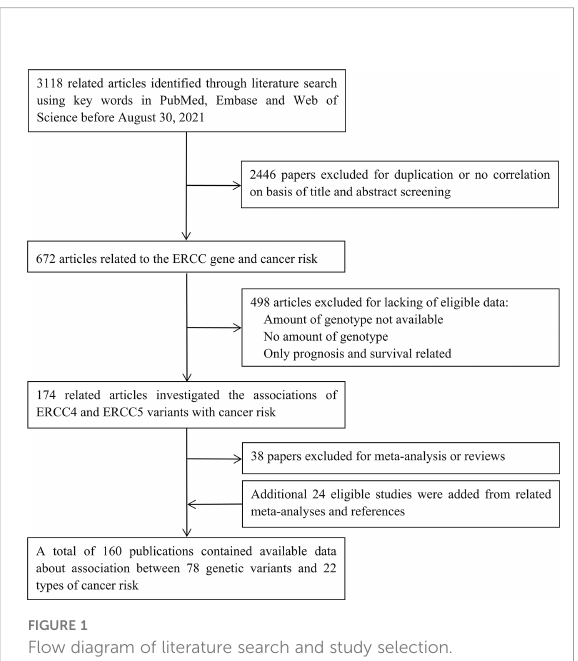
FIGURE 1 Flow diagram of literature search and study